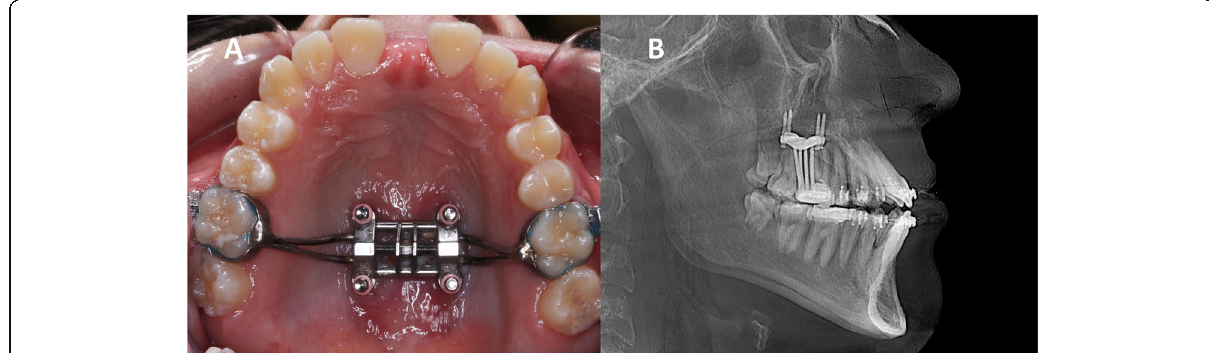
Fig. 1 Midfacial skeletal expander (MSE). a Intraoral occlusal view. b X-ray showing bicortical engagement of